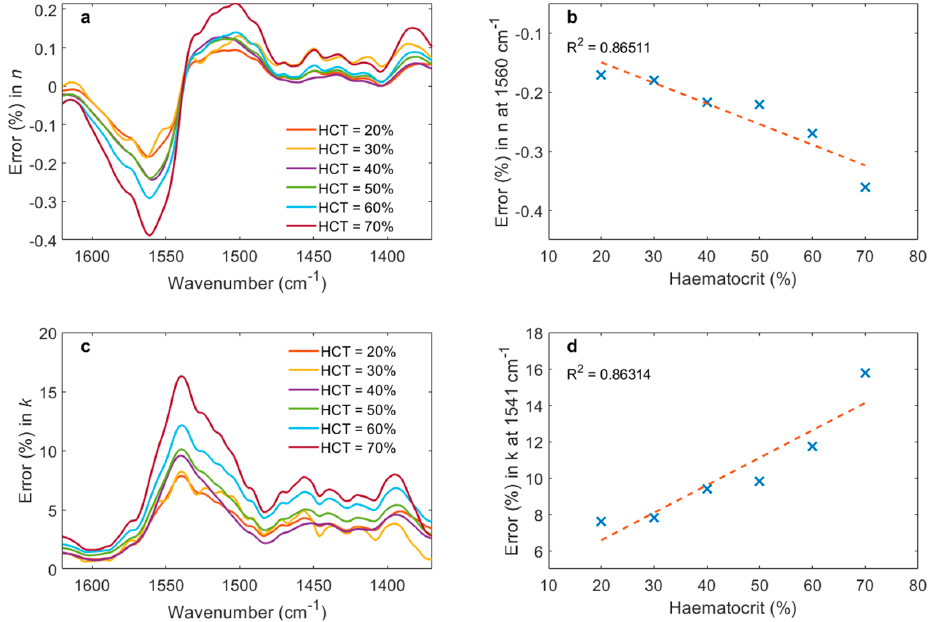
Figure 5. Error in ( a ) real and ( c ) imaginary parts of plasma refractive index due to haematocrit in the range 20–70%: ( b ) shows the maximum error in n, which occurs at 1560 cm − 1 , with respect to haematocrit; ( d ) shows the corresponding behaviour for k , which occurs at 1541 cm − 1 . Figure 5 shows the percentage error of (a) n and (b) k introduced by whole blood with haematocrit in the of range 20–70% relative to those of plasma, which has had all cellular content removed by centrifugation. The plots show the region of the highest error, which is in the range of 1370–1620 cm − 1 . Figure 5c shows regression analysis for the error of n at 1560 cm − 1 , which is the frequency of the highest error. Figure 5d shows the equiva- lent data for k , where the maximum error occurs at 1541 cm − 1 . The data in Figure 5c and d can be used to extrapolate the error in the plasma refractive index due to haematocrit in the healthy adult range of haematocrit = 35–48%. For n , this corresponds to error = 0.20– 0.25%. For k , this corresponds to error = 8.8–11%. The fact that the peaks in error for n and k occur at different frequencies is an artefact of the relationship between the real and im- aginary components of a complex value, where a peak in one corresponds to a zero in the other. 4. Discussion Haematocrit influences evanescent mid-infrared characterisation of plasma in meas- urements of whole blood, as illustrated in Figure 1. The fact that absorbance varies with haematocrit indicates that cells do at least partially occupy the evanescent field and there- fore cannot be assumed to not interfere with such measurements. The main contributions of changing haematocrit are in the fingerprint region between 850 and 1750 cm − 1 , which will interfere with absorption peaks corresponding to proteins, DNA, and drugs. This information is important for the quantitative processing of spectroscopic data. For example, it is necessary to account for haematocrit in bioanalytical MIR measurements when identifying the spectroscopic signature of a biomarker or when analysing the time- resolved pharmacokinetic response of a patient to a medicine. This could affect different methods in different ways. A regression algorithm based upon the change in the magnitude of absorption for a drug-specific fingerprint would be required to demonstrate that the change is not due to patient variability in haematocrit. If an exploratory analysis technique, such as principal component analysis, is used to find